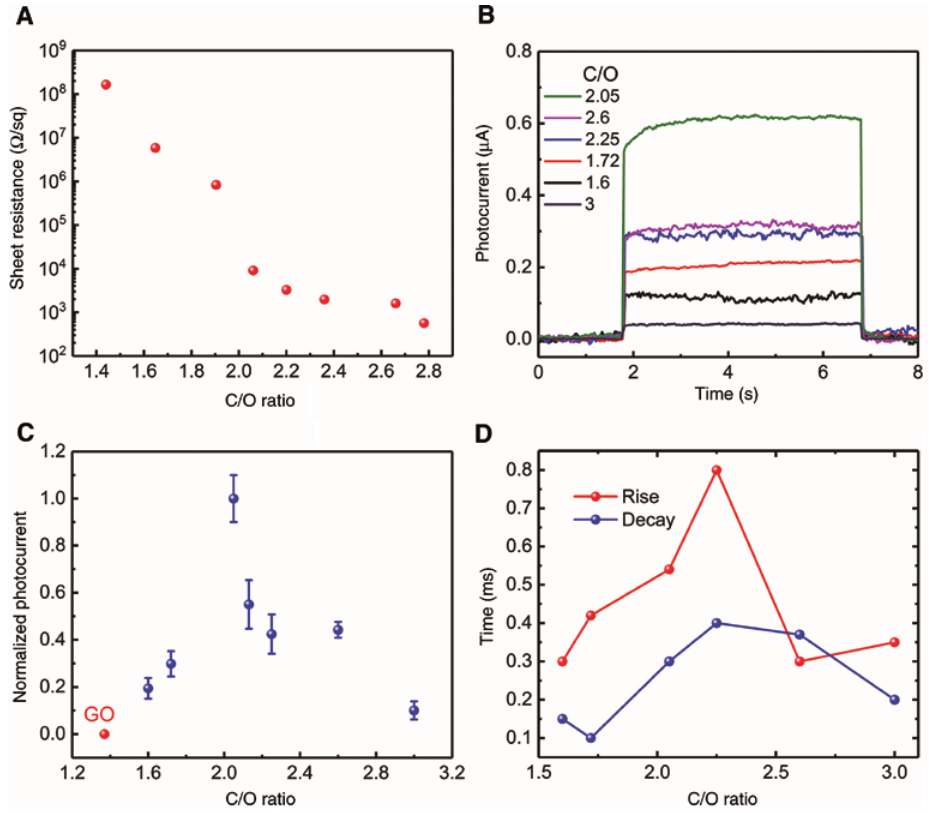
Figure 2: Impact of C/O ratio on the electrical and optoelectronic performance of rGO films. (A) Sheet resistance as a function of C/O ratio. (B) Photoresponse of rGO devices with different C/O ratios. (C) Normalized photocurrent with error bars from rGO devices (blue points) with different C/O ratios. Negligible photocurrent can be obtained from GO devices (red point). (D) Rise (red) and decay time (blue) of rGO detectors with different C/O